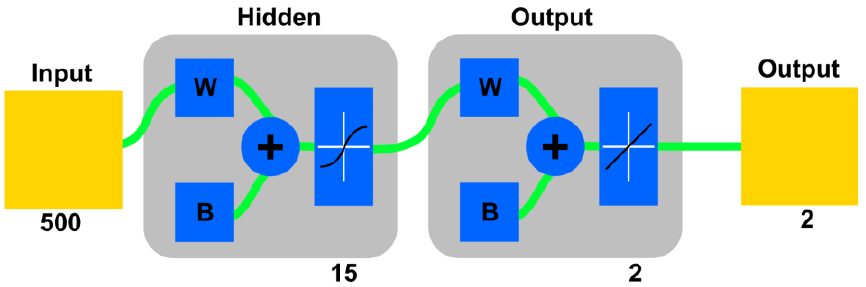
Figure 6. Cotton threads: the architecture of neural network traction properties (Adapted from [11]).